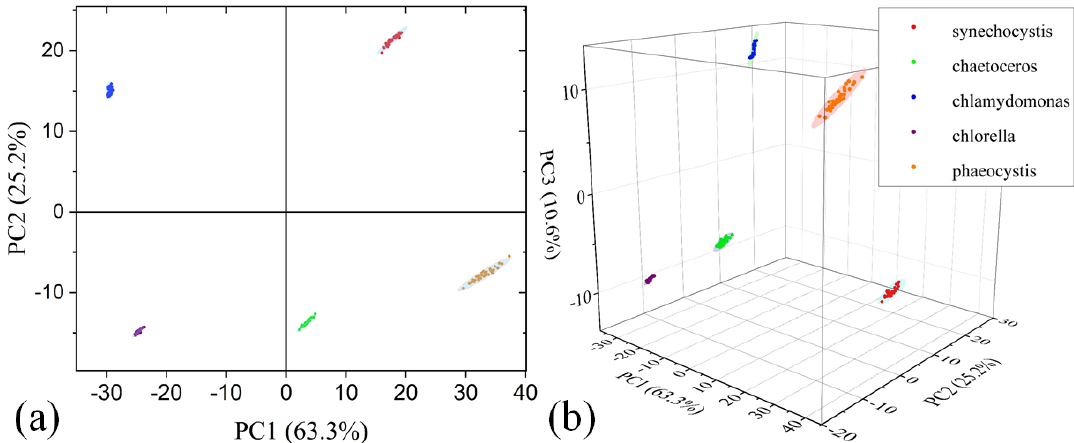
Figure 6. Classification with the experimental data for five disaster-causing algae samples. ( a ) The relationship between principal component (PC)1 and PC2. ( b ) The relationship among PC1, PC2 and PC3.